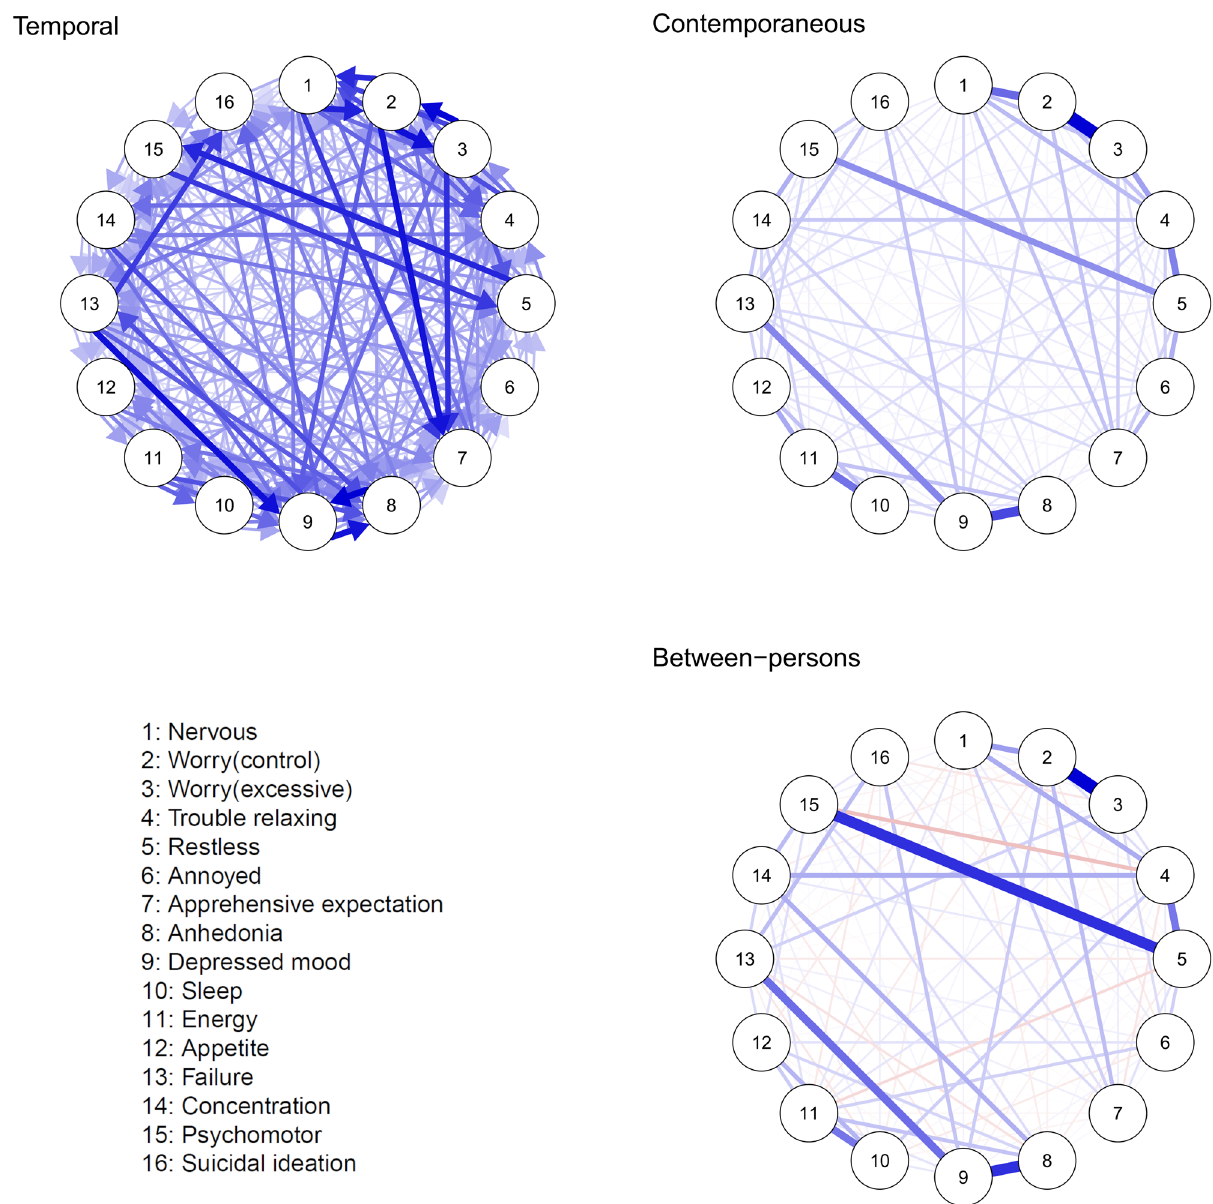
Figure 2. Panel graphical VAR model. Circles represent symptoms, and connections (undirected drawn as lines or directed drawn as an arrow) indicate predictive relationships. Blue lines indicate positive relationships, red lines indicate negative relationships. The width and saturation of a line indicates the strength of the relationship. In the temporal network (left), directed lines indicate where a symptom predicts another symptom at the next session after controlling for all other variables. Within the contemporaneous (middle) lines represent partial correlations between symptoms at the same timepoint, after controlling for all other variables and temporal effects. The between-persons network (right) indicating partial correlations between stable averages. We only plot significant edges, and the visualisation of autocorrelations in the temporal network has been omitted to improve visualisation; a figure including autocorrelations can be found in supplementary